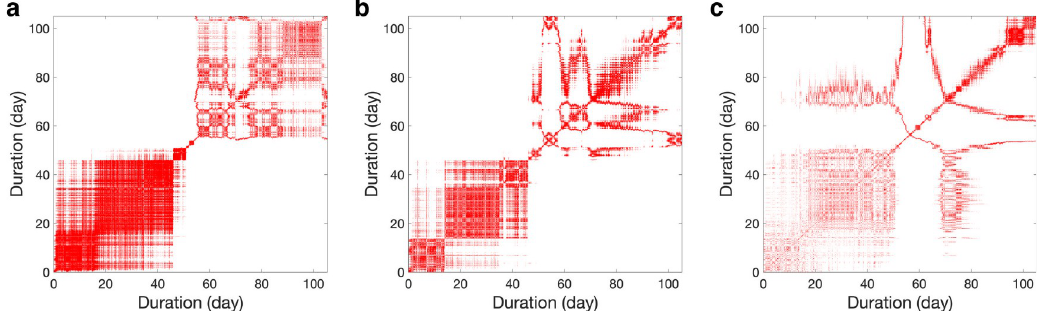
Fig 3. Recurrence plot. The recurrence plot of the Pearson correlation coefficients of (a) polyp A, (b) polyp B, and (c) polyp C.